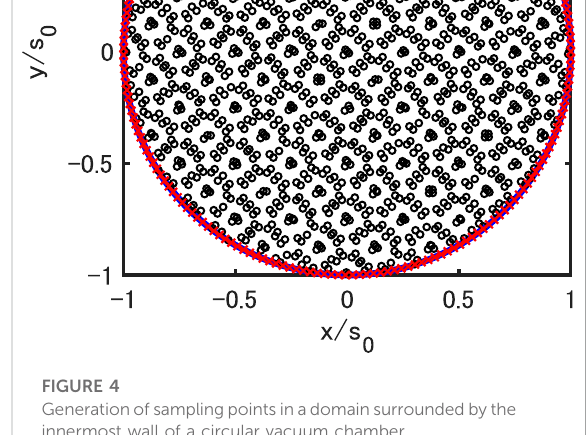
FIGURE 4 Generationofsamplingpointsinadomainsurroundedbythe innermost wall of a circular vacuum